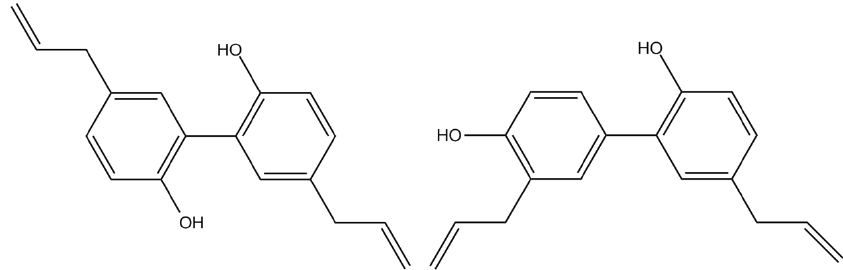
Figure 1. Chemical structures of MN ( left ) and HK ( right ).